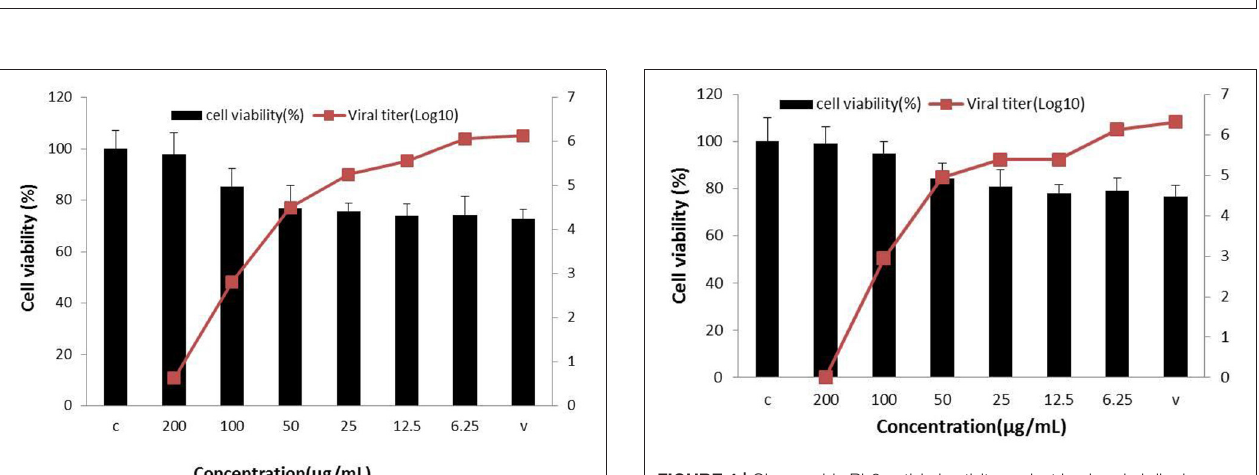
FIGURE 2 | Antiviral activity of compounds. All compound concentrations were used with 200 µ g/ml, and uninfected and virus infected cells were used as control. The data are expressed as the mean of three experiments.